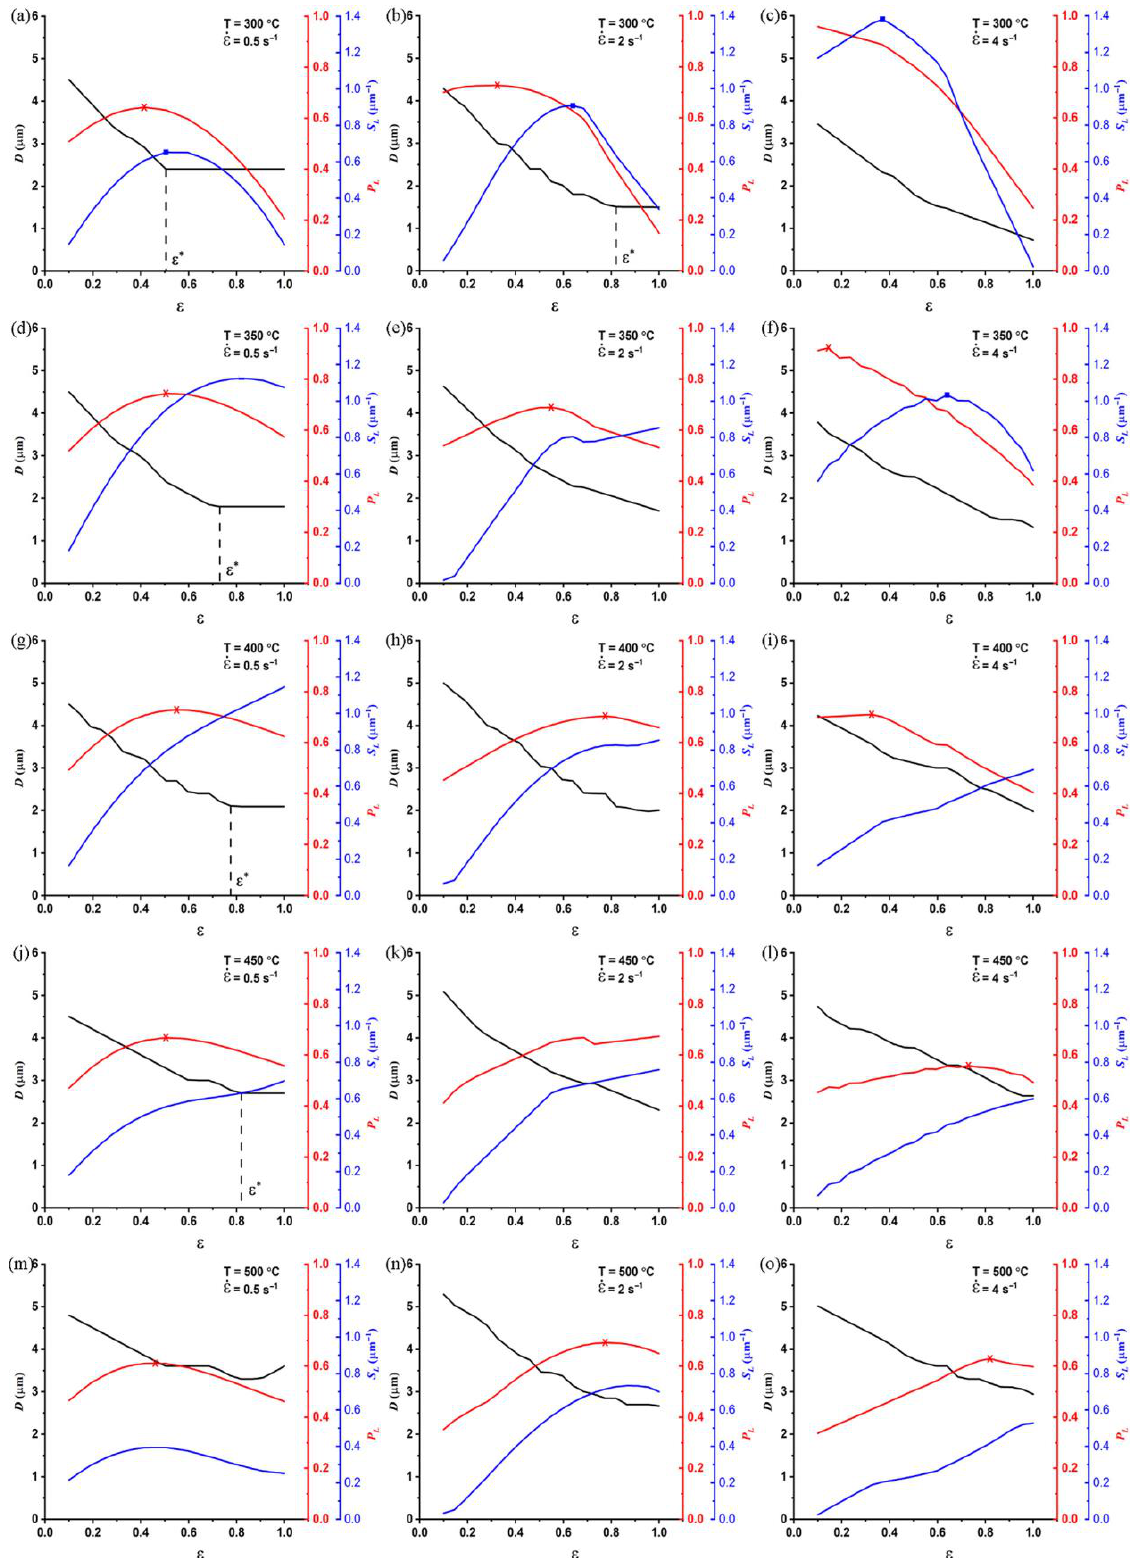
Figure 17. The average grain diameter D , and the fraction L P and density L S of low-angle boundaries as dependent on temperature T , strain ε , and strain rate . The dependences are given for temperature, °C: ( a – c ) 300; ( d – f ) 350; ( g – i ) 400; ( j – l ) 450 and ( m – o ) 500.